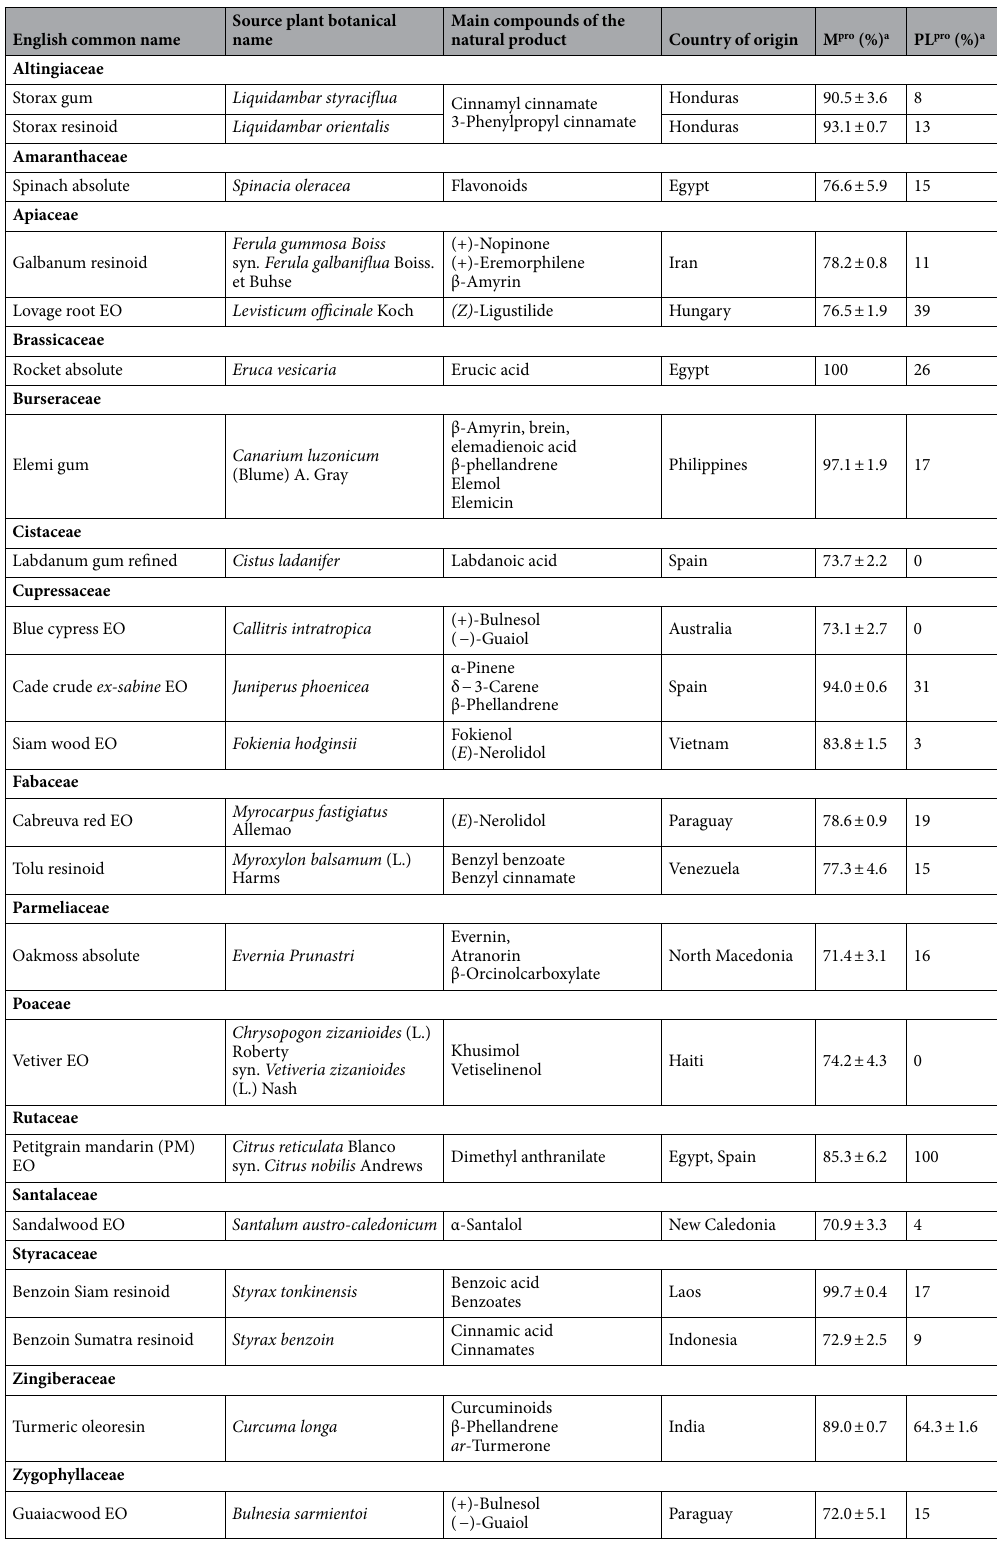
Table 1. Inhibitory activities of selected F&F materials against SARS-CoV-2 cysteine proteases. a Inhibitory activity of each F&F material at a concentration of 50 µg/mL. Numbers represent the mean value from two experiments (inhibition < 50%) or five experiments (inhibition >